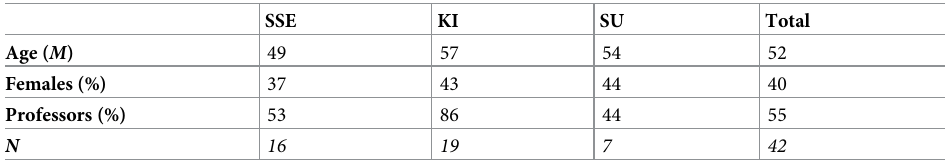
Table 1. Descriptive statistics of